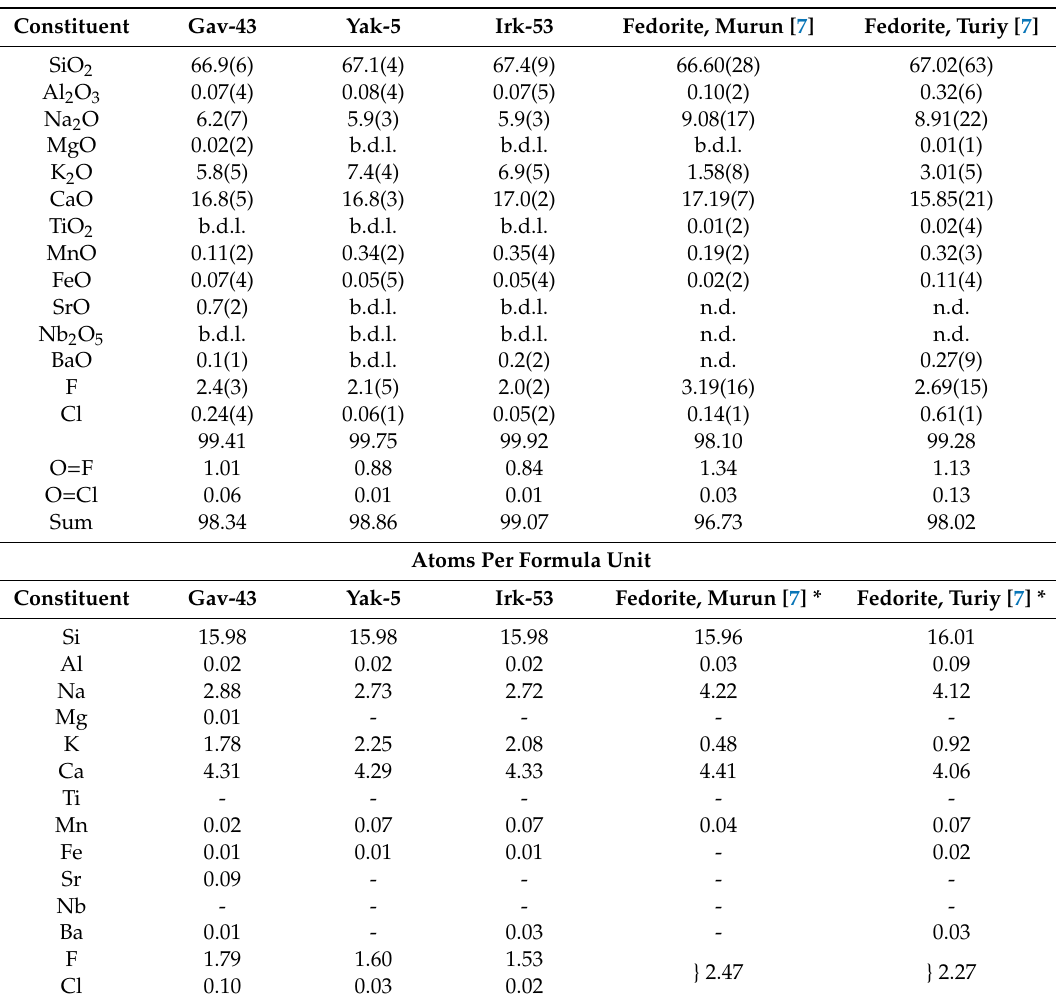
Table 1. Average chemical composition (wt.%) and atomic proportions (apfu) calculated on the basis of 16(Si + Al) for the studied fedorite samples (averaged for 8–12 analyses) compared with fedorite from the Malyy (Little) Murun and Turiy complexes, obtained by